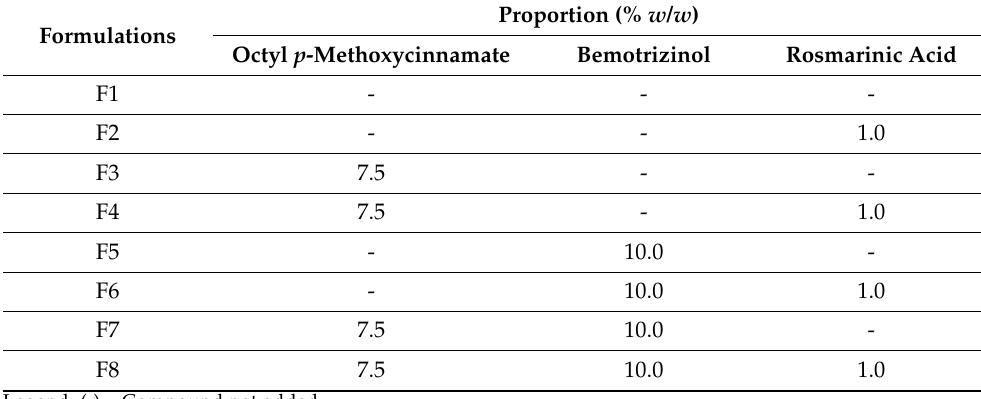
Table 1. Experimental design of factorial type (DoE 2 3 ) applied to the development of photoprotective formulations. Proportion (% w / w ) Formulations Octyl p -Methoxycinnamate Bemotrizinol Rosmarinic Acid F1